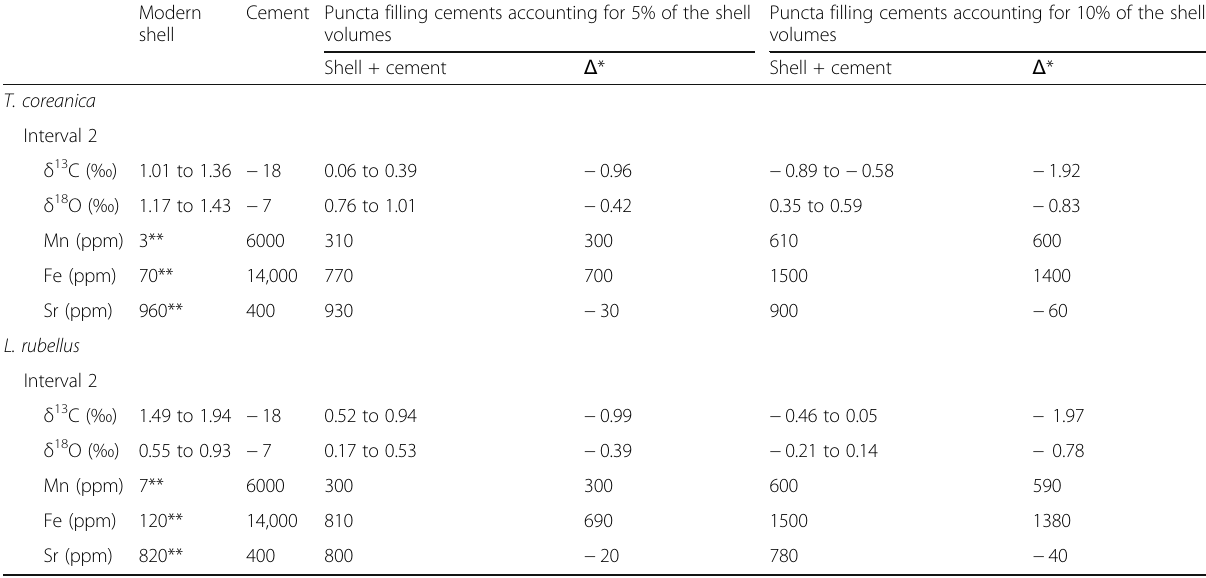
Table 2 Effect of puncta-filling cements to the isotopic composition and minor element concentrations of shell samples. We assume that the isotopic composition and minor element concentrations of the puncta-filling cements are identical to those of the cement formed by meteoric diagenesis. Then, we calculate the isotopic composition and minor element concentrations of the mixtures of shell and puncta-filling cements when the punctae are filled with such cements Modern Cement Puncta filling cements accounting for 5% of the shell Puncta filling cements accounting for 10% of the shell shell volumes